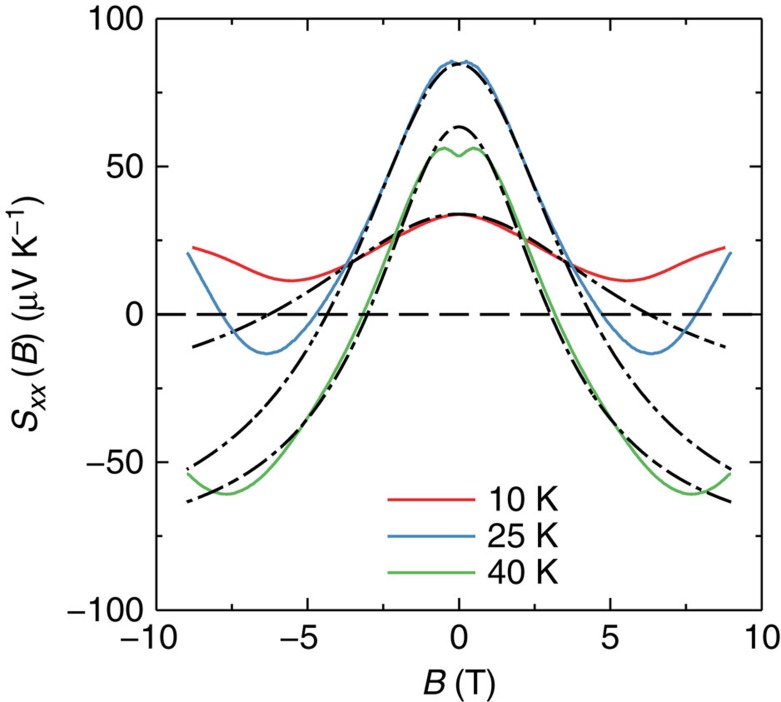
Fit the thermopower Sxx to equation (6).T=10(red), 25(blue) and 40 K(light green). Dash–dot lines are fitting curves.